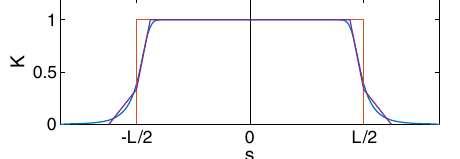
FIG. 3. Focusing gradient profile K ð s Þ for a realistic quadru- pole magnet (blue) and the hard-edge model (red). The purple profile is the bilinear profile for testing the fringe field modeling